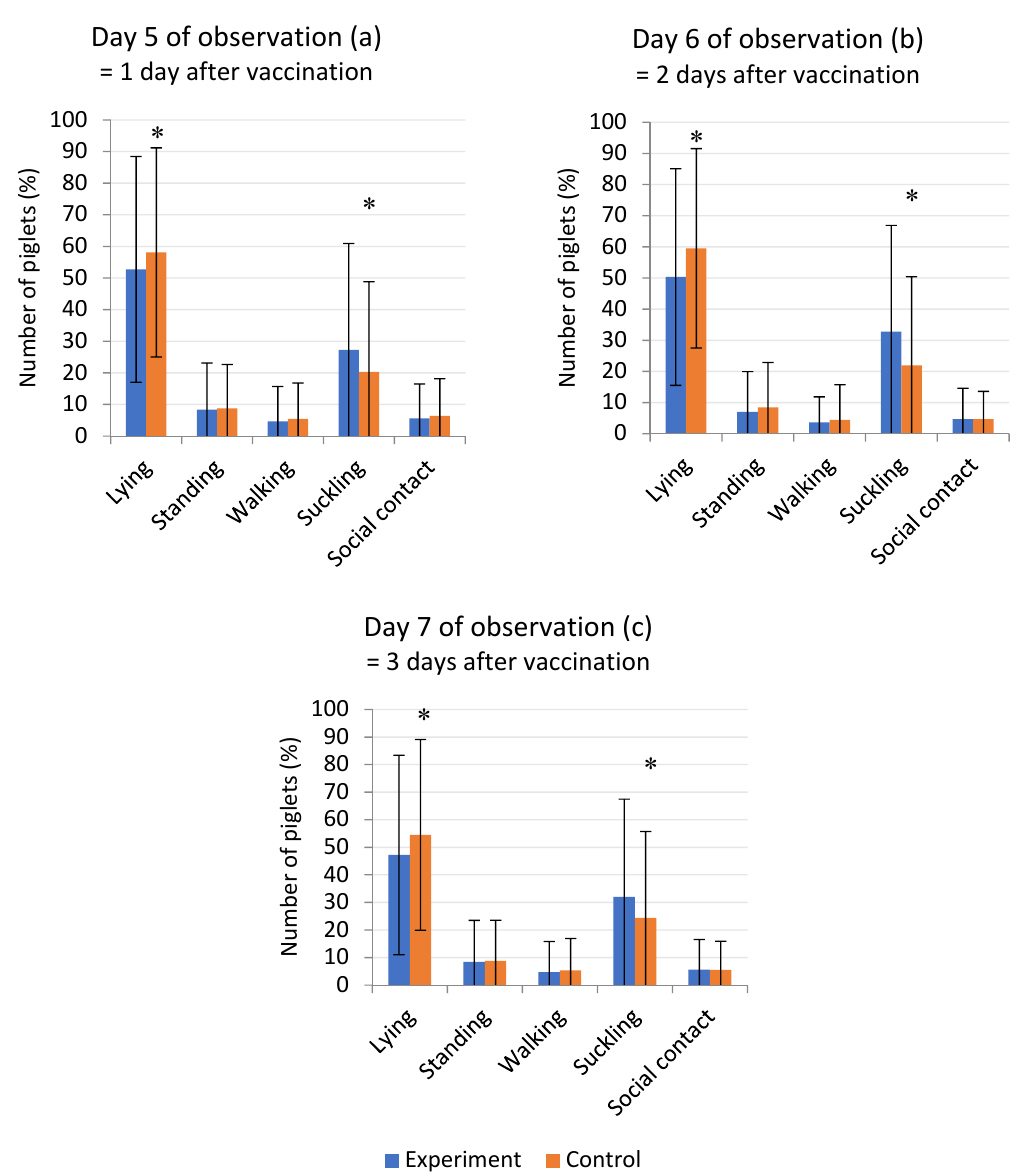
Figure 2. Percentage of piglets per litter (means and standard deviations) showing different behaviors in the experimental and control groups on the three days after vaccination ( a – c ). * p < 0.01.